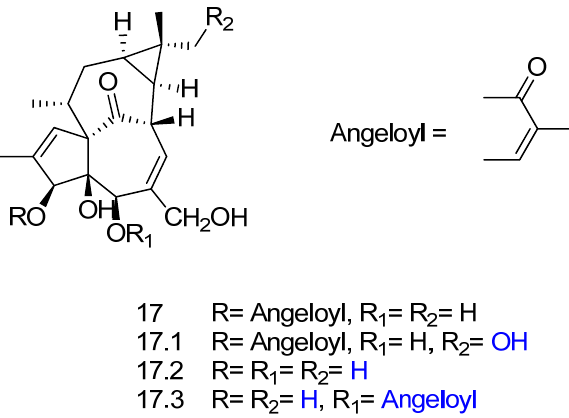
Figure 18. Chemical structures of ingenol ‐ 3 ‐ angelate ( 17 ) and its derivatives 17.1 , 17.2 , and 17.3 obtained by biotransformation with plant cell cultures [66] .